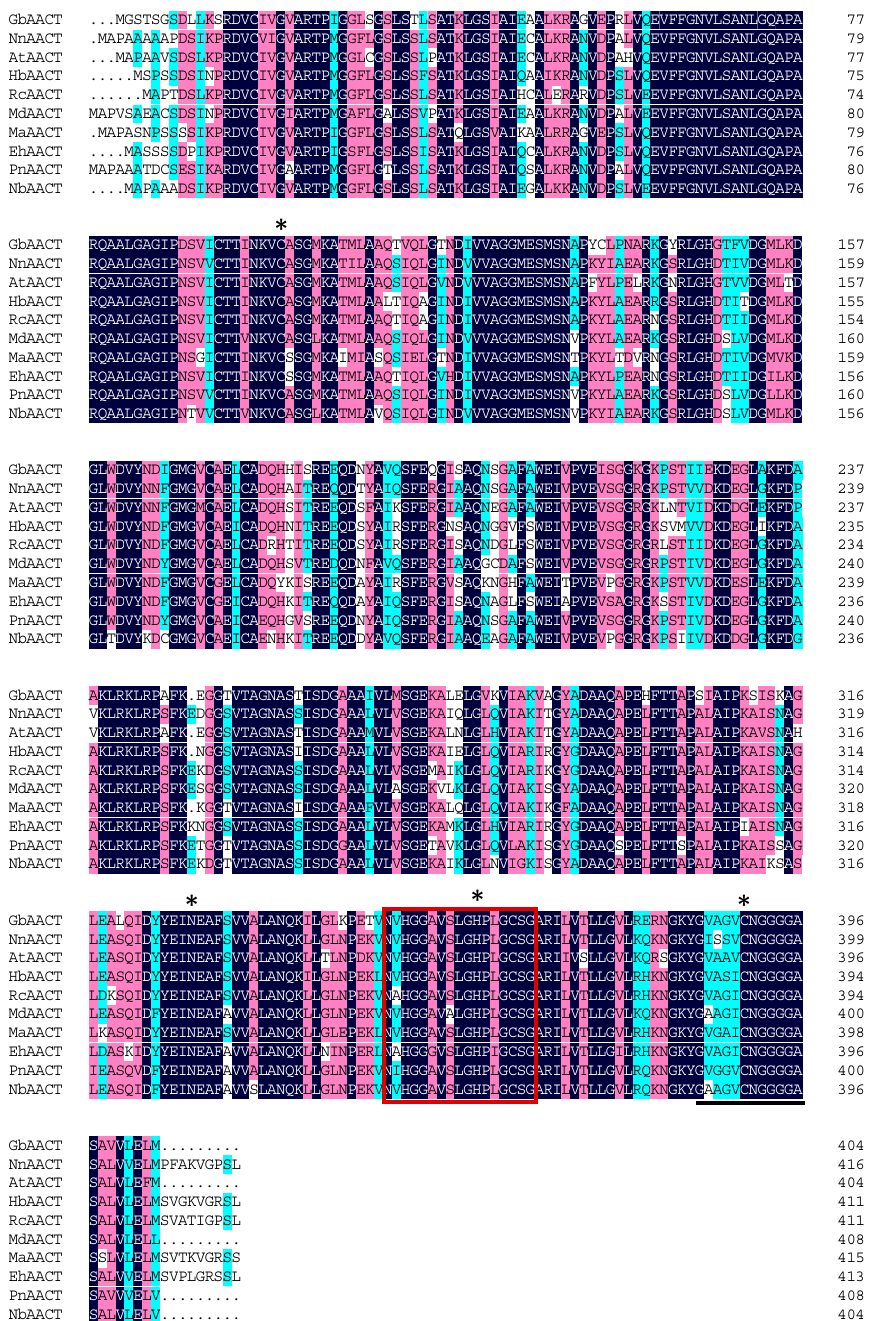
Figure 2. Amino acid sequence multiple alignments of GbAACT with other plant AACTs from Nelumbo nucifera (NnAACT, Accestion No. XP_010267976.1), Amborella trichopoda (AtAACT, Accestion No. XP_011628272.1), Hevea brasiliensis (HbAACT, Accestion No. AFJ74323.1), Malus domestica (MdAACT, Accestion No. XP_008365553.1), Morus alba (MaAACT, Accestion No. ALD84318.1), Euphorbia helioscopia (EhAACT, Accestion No. ALC76524.1), Panax notoginseng (PnAACT, Accestion No. AIK21787.1), Nicotiana benthamiana (NbAACT, Accestion No. BAR94039.1). Dark blue: identity = 100%; red: 75% ≤ identity < 100%; light blue: 50% ≤ identity < 75%. The active sites of amino acid residues are marked with asterisk, Conserved domain (NVHGGAVSIGHPIGCSG) is marked with red frame, thiolase II active sites (GVAGVCNGGGGASA) are underlined.